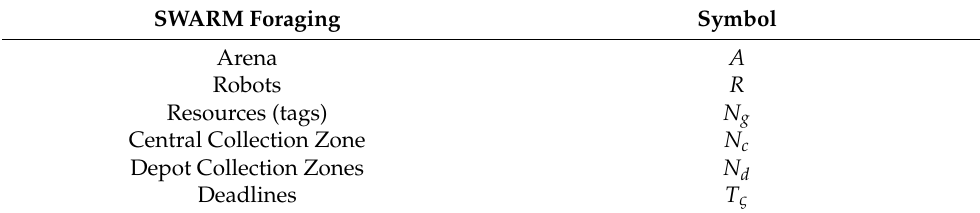
Table 1. ED_foraging analogy. SWARM Foraging Symbol Arena A Robots R Resources (tags) N g Central Collection Zone N